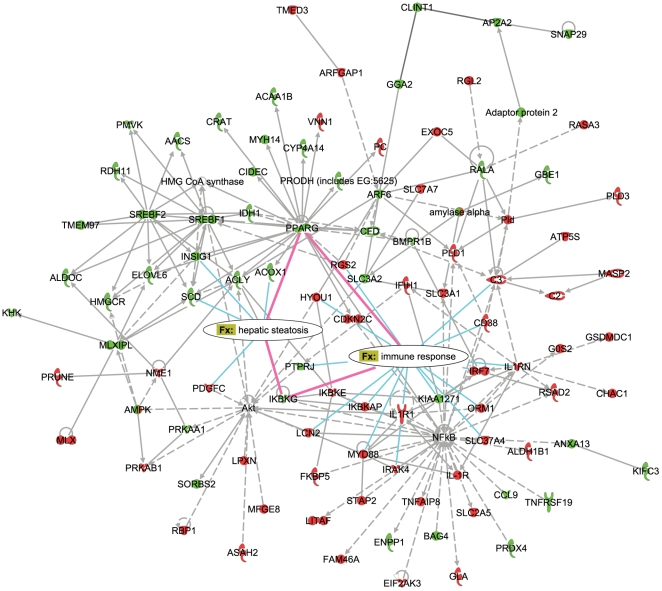
Molecular network underlying hepatic response to high-fat diets (day 3).The global molecular associations of the high-fat responsive genes are functionally characterized and divided into networks based on the functions and/or diseases that are most significant to the network objects (Ingenuity Pathway Analysis). Depicted is the result of merging the network 1 (Immune Response, Tissue Development, Skeletal and Muscular System Development and Function), network 2 (Cellular Development, Connective Tissue Development and Function, Lipid Metabolism) and network 4 (Hepatic System Disease, Liver Steatosis, Cancer). The overrepresented “Function and disease” (Fx) categories “immune response” and “hepatic steatosis” are overlaid onto resulting network, showing which genes (nodes) are directly involved in these processes. The interactions between nodes that are directly connected to both processes are highlighted in pink. Color coding of the nodes corresponds to the direction of gene expression changes at day 3 in HFBT vs. chow diet comparison (upregulated genes are shown in red and downregulated in green).